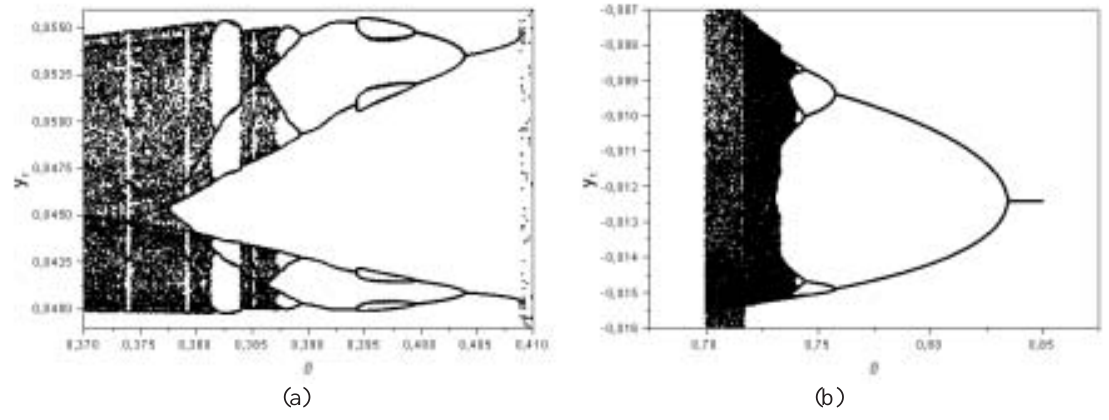
Fig. 14. Bifurcation diagram varying temperature parameter θ . (a) 0 . 37 (cid:1) θ (cid:1) 0 . 41 ; (b) 0 . 70 (cid:1) θ (cid:1) 0 . 85 . the same values. The evolution of Lyapunov exponents is shown in Fig.